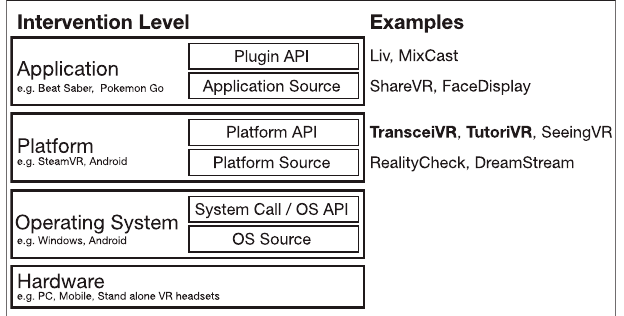
FIGURE4| DifferentlevelsofinterventioninthesoftwarestackforMixed Reality applications.